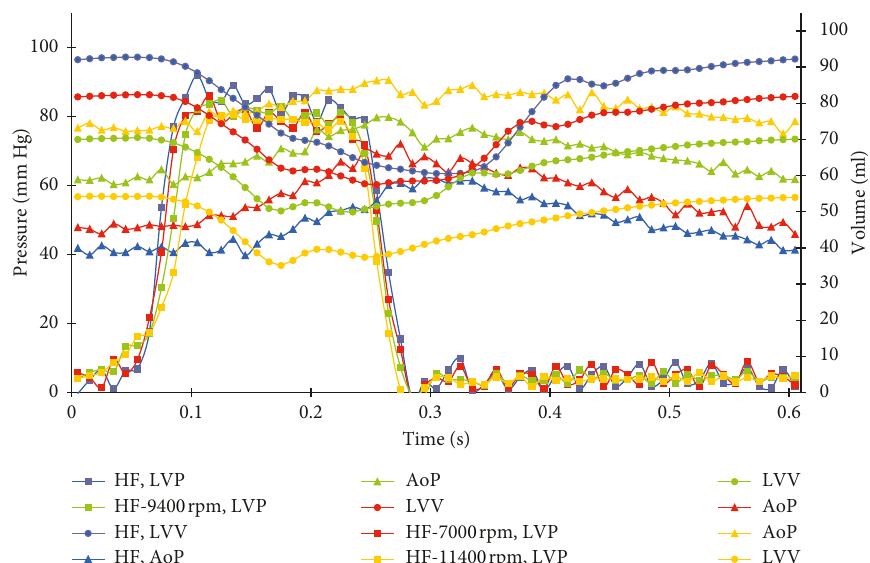
Figure 10: Time courses of the left ventricular (LV) pressure and volume; aortic pressure for acute heart failure in pediatric patient with body weight of 15.2kg at the various pump speeds for partial support (red), partial-to-full support change (green), and total work attainment of a normal LV stroke work level (yellow). Blue lines represent time courses of condition characteristics simulated without